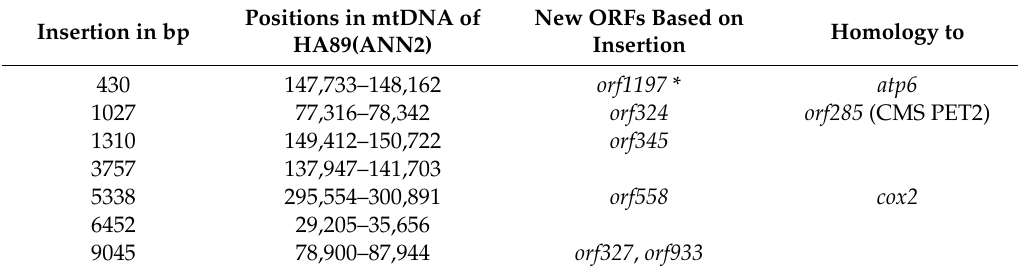
Table 3. Localization of insertions (>100 bp) in the mitochondrial genome of HA89(ANN2) CMS line.